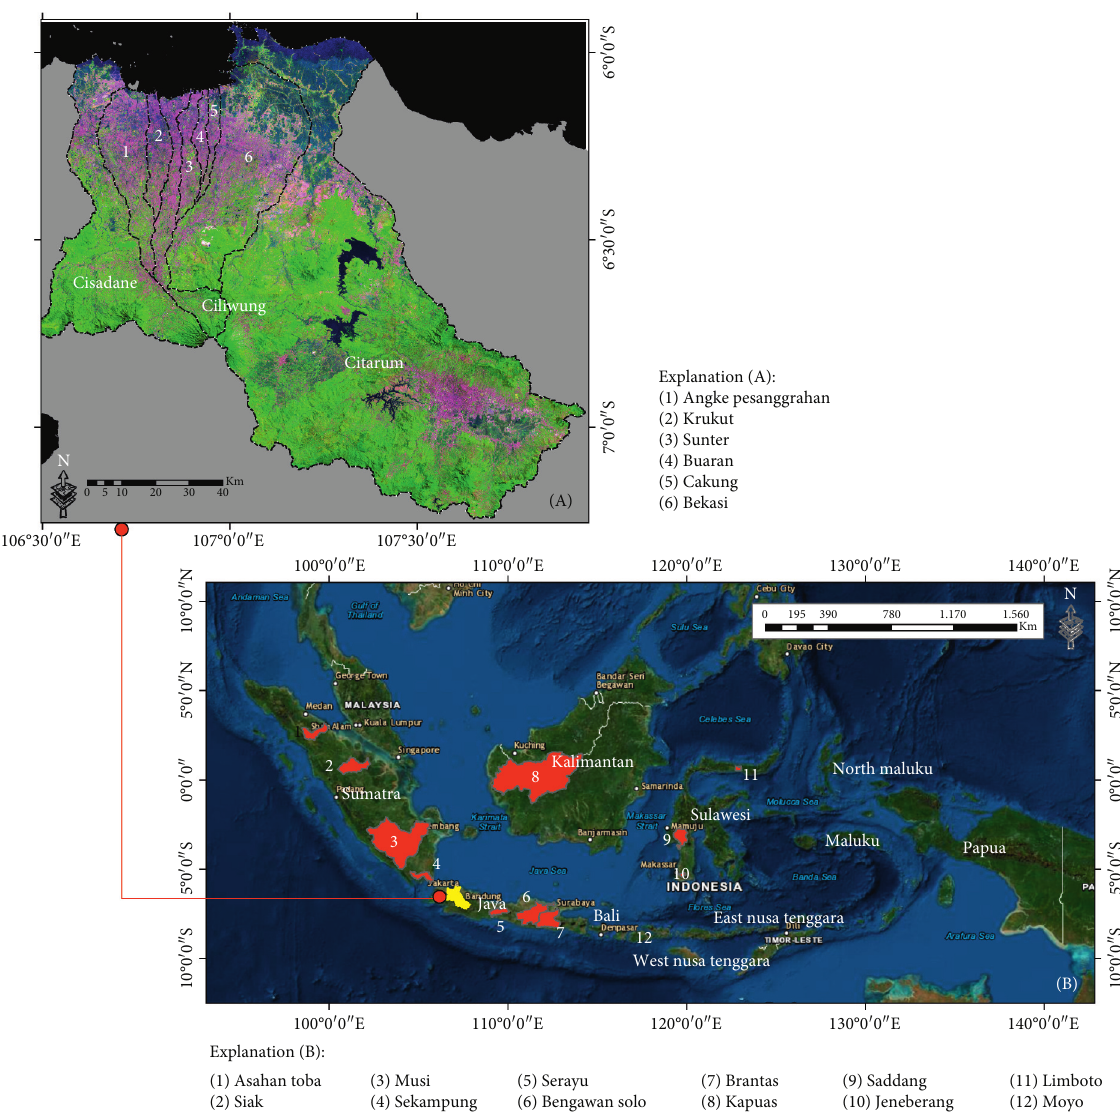
Figure 1: The 15 national priority watersheds in Indonesia: (a) test case study areas in the Citarum, Ciliwung, and Cisadane watersheds; (b) another priority watershed location for the implementation of the method